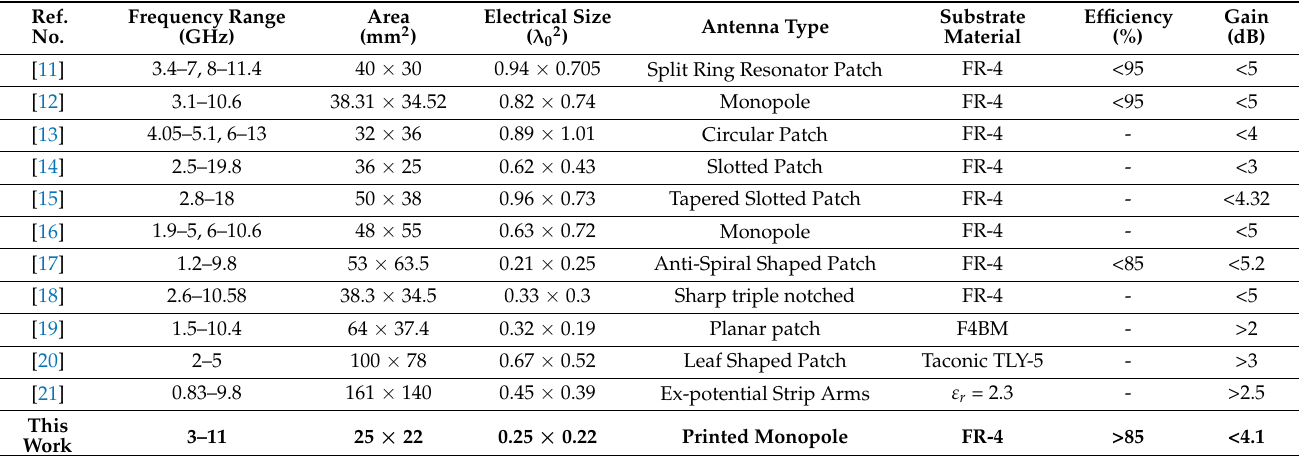
Table 1. Comparison with the previous